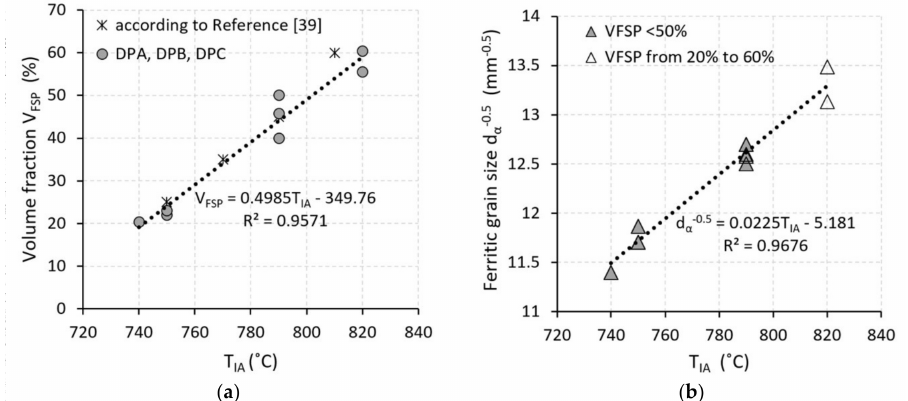
Figure 7. The dependencies of the structure parameters: ( a ) the volume fraction of the secondary phases; ( b ) the ferritic grain size and the annealing